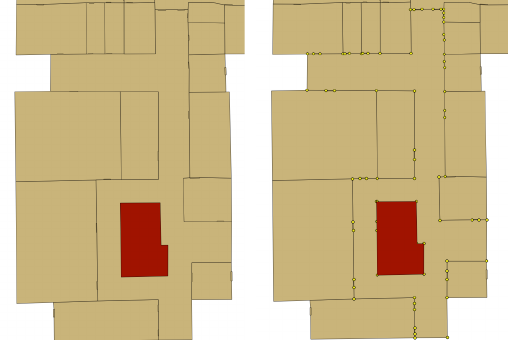
Figure 4. Inward offsetting & sampling of the contour points